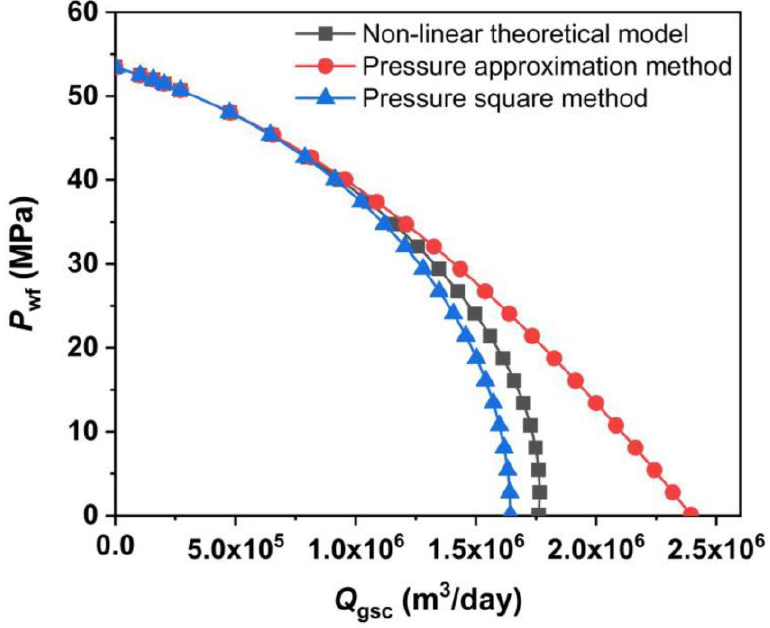
Figure 12. Inflow performance relationship of different methods .